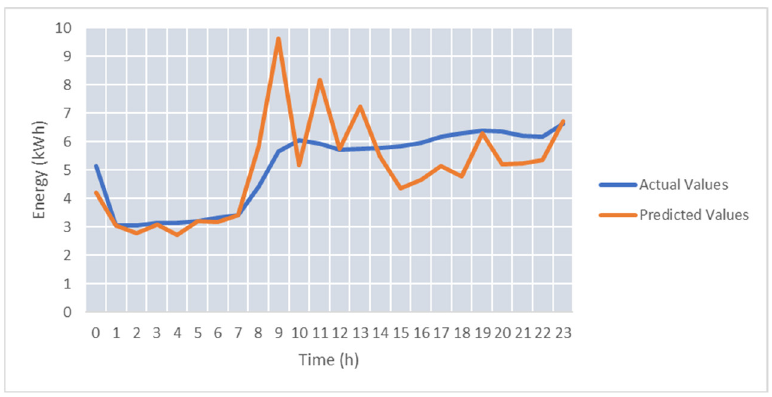
Figure 11. TC-S2: best day (SMAPE = 14.9%), with only energy features.